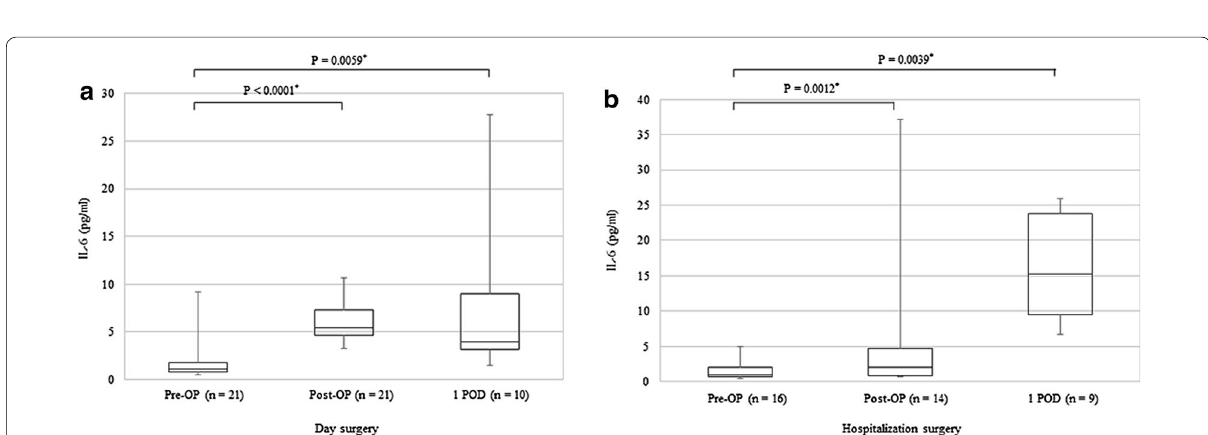
Fig. 4 Changes in IL-6 levels before surgery, after surgery, and on the first postoperative day in patients undergoing day surgery ( a ) versus hospitali- zation surgery ( b ) for breast cancer. Median values are expressed with interquartile ranges in the box plot. *P < 0.05 versus after surgery and on the first postoperative day (Wilcoxon matched pairs test). Pre-OP before operation, Post-OP after operation, 1 POD first postoperative